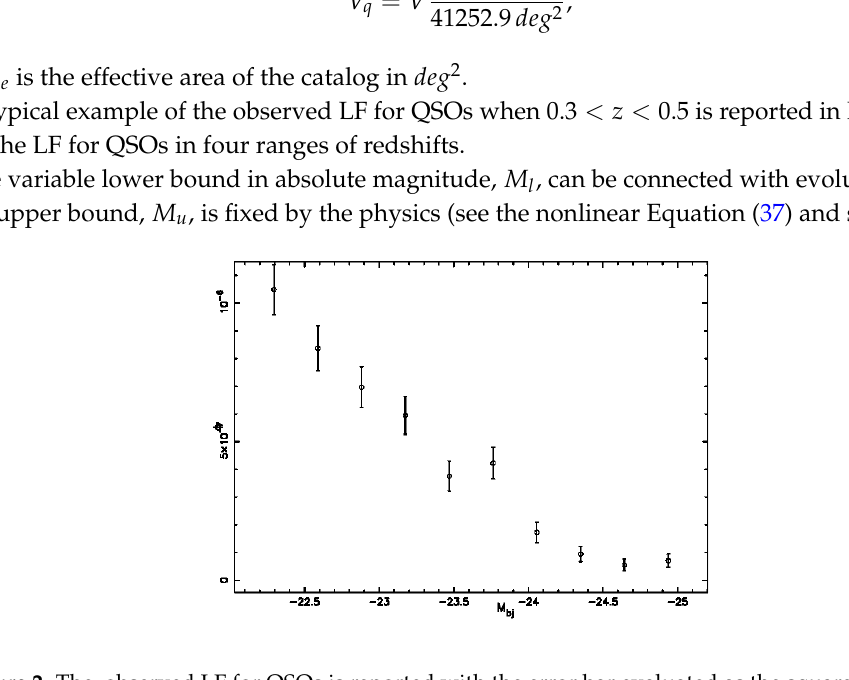
Figure 2. The observed LF for QSOs is reported with the error bar evaluated as the square root of the LF (Poissonian distribution) when z [ 0.3,0.5 ]